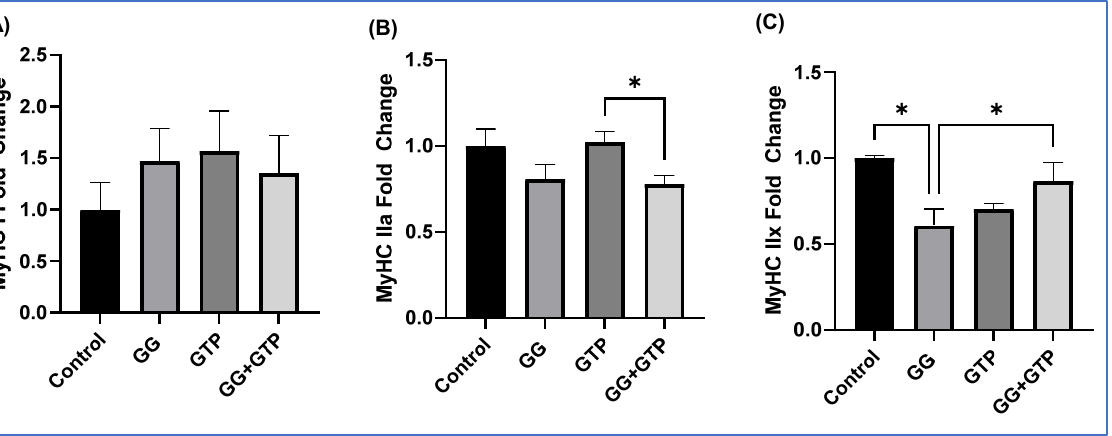
Figure 4. The effects of GGOH and GTP supplementation on myosin heavy-chain isoform mRNA gene expression in soleus muscle. ( A ) MyHC-I, ( B ) MyHC IIa, ( C ) MyHC IIx. n = 4 control; n = 5 GG, GTPs, and GG + GTPs, respectively. Control, HFD only; GG, HFD supplemented with GGOH in 400 mg/kg diet; GTPs, HFD supplemented with 0.5% weight/volume GTPs in water; GG + GTPs, HFD supplemented with a combination of GGOH and GTPs; MyHC, myosin heavy chain; *, p < 0.05 by Fisher’s Least Significant Difference (LSD) test post hoc analysis.